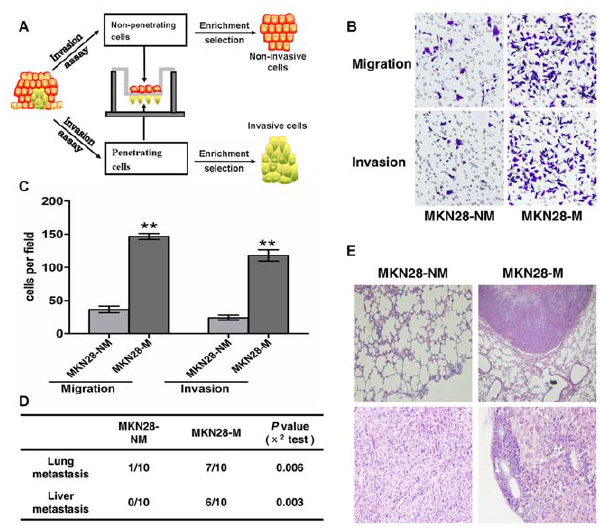
Figure 1. The metastatic characteristics of each cell subline. (A) General scheme of the establishment of invasive and non-invasive cell sublines derived from human GC cell lines. (B,C) In vitro migration and invasion activity of each cell subline . Migration and invasion activities were measured in vitro with transwell chambers, as described in Materials and Methods. Photos are representative fields of invasive cells on the membrane. Magnification, 100x. Bar graphs represent the average number of cells on the underside of the membrane 6 SE. ** P , 0.01 as compared with non-invasive cells, analyzed by t -test. (D and E) Metastasis potential of each cell subline in vivo (n=10). (D) The incidence of metastasis in mice that received intravenous tail injections of each selected cell subline. (E) H&E staining of lungs and livers isolated from mice that received intravenous tail injections of MKN28-NM and MKN28-M cells, respectively. Magnification,